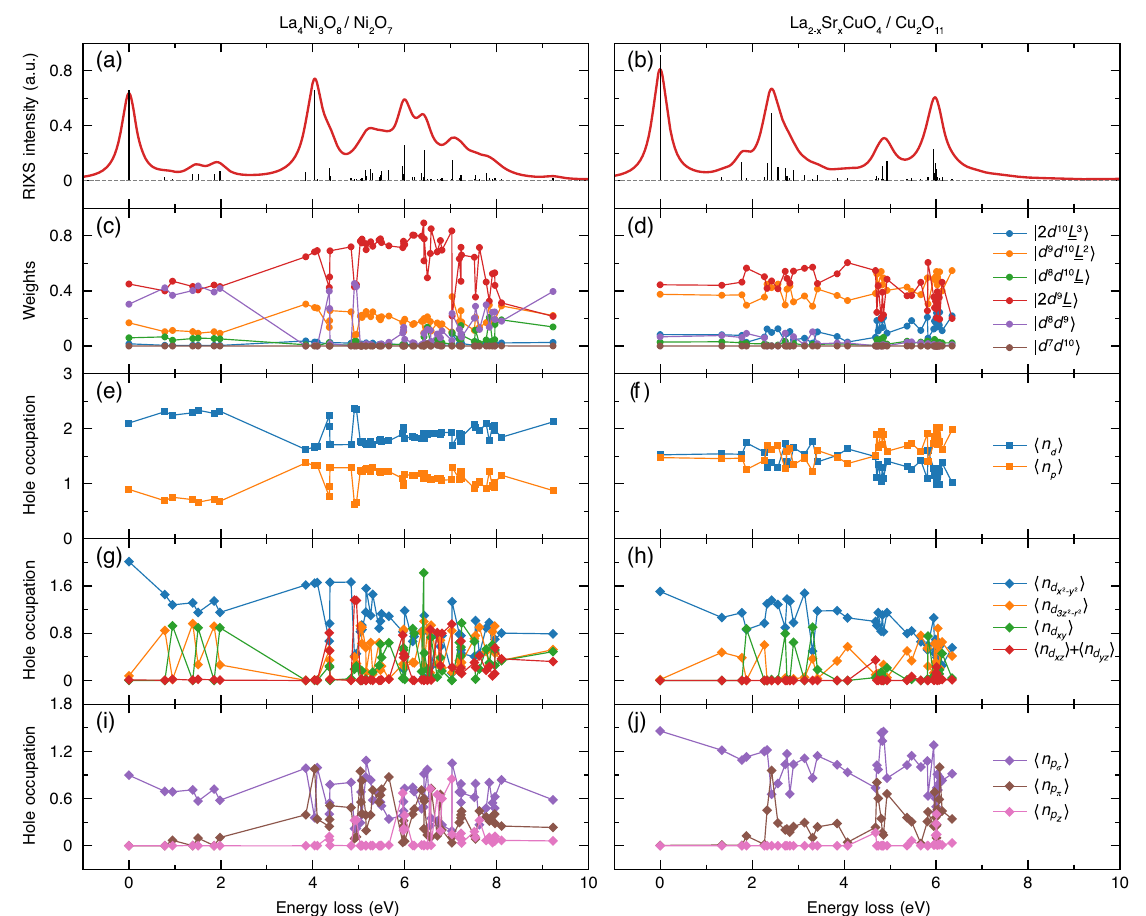
FIG. 5. Wave-function analysis of Ni 2 O 7 and Cu 2 O 11 clusters with three holes. (a,b) Calculated unbroadened RIXS intensity (black vertical lines) and broadened RIXS spectra (red curves) with θ ¼ 60 ° and σ polarization. Note that in this geometry, the contribution from p orbitals is minimized. (c,d) Weights of different configurations of the ground and excited states. (e,f) Hole occupations of TM 3 d z and O 2 p orbitals. (g,h) Hole occupations for each type of 3 d orbital. (i,j) Hole occupations for each type of 2 p orbital. Only the excited states with unbroadened RIXS intensity stronger than 1% of the maximum value are shown.